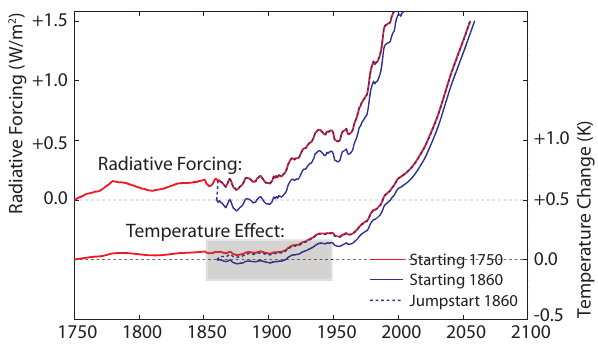
Fig. 3. Radiative forcing and temperature evolutions illustrating the “cold start problem” (Hasselmann et al., 1993). A climate model run taking into account the forcing history since 1750 (red line) provides a different future projection compared to a run taking into account deviations from a later startyear only, e.g. 1860 (blue solid line). A later common reference period, e.g. 1980–1999, or a “jump start” with radiative forcing being applied relative to 1750 (blue dashed line), minimizes this initialization problem. The tempera- ture response for the “jump start” run asymptotically approaches the results for the run starting in 1750 (grey shaded